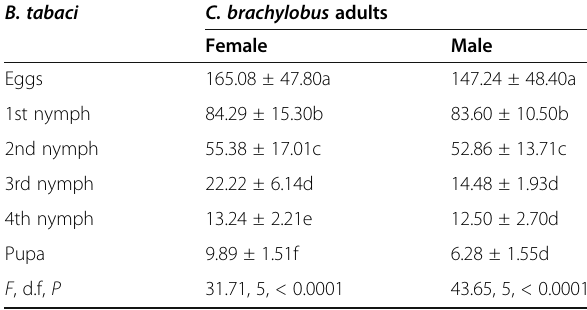
Table 3 Average prey consumption (mean ± S.E) by